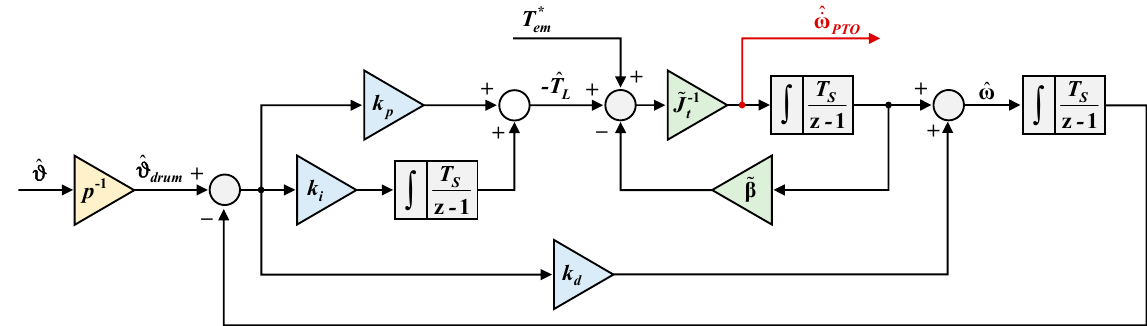
Figure 8. Block diagram of the conventional position-tracking observer (PTO) (the variable “z” is used to indicate the observer’s discrete-time implementation).